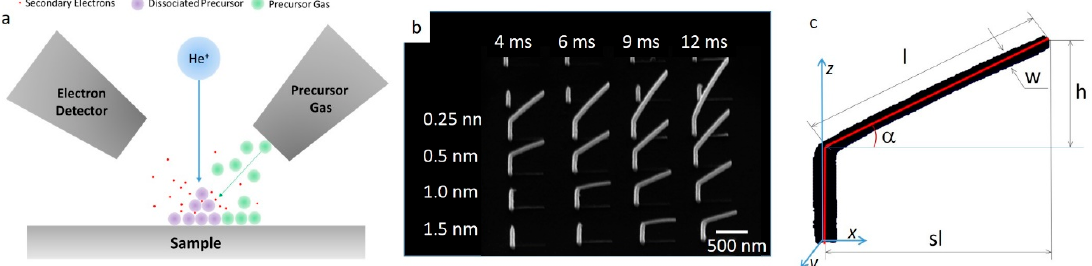
Figure 1. Focused-ion-beam-induced deposition (FIBID) diagram, calibration structure growth, and parametrization. ( a ) FIBID process in the helium ion microscopy (HIM) diagram, different structures are obtained by changing the beam pitch. ( b ) PtC structure array, made at 25 kV, 0.54 pA beam current with a 5 µ m aperture with 8.142 mm working distance, columns are varying dwell times of 4, 6, 9, and 12 ms, and rows are varying pitch of 0.25, 0.5, 1.0 and 1.5 nm, respectively. ( c ) An example of a parametrized pillar grown for calibration of growth parameters with pillar values extracted.